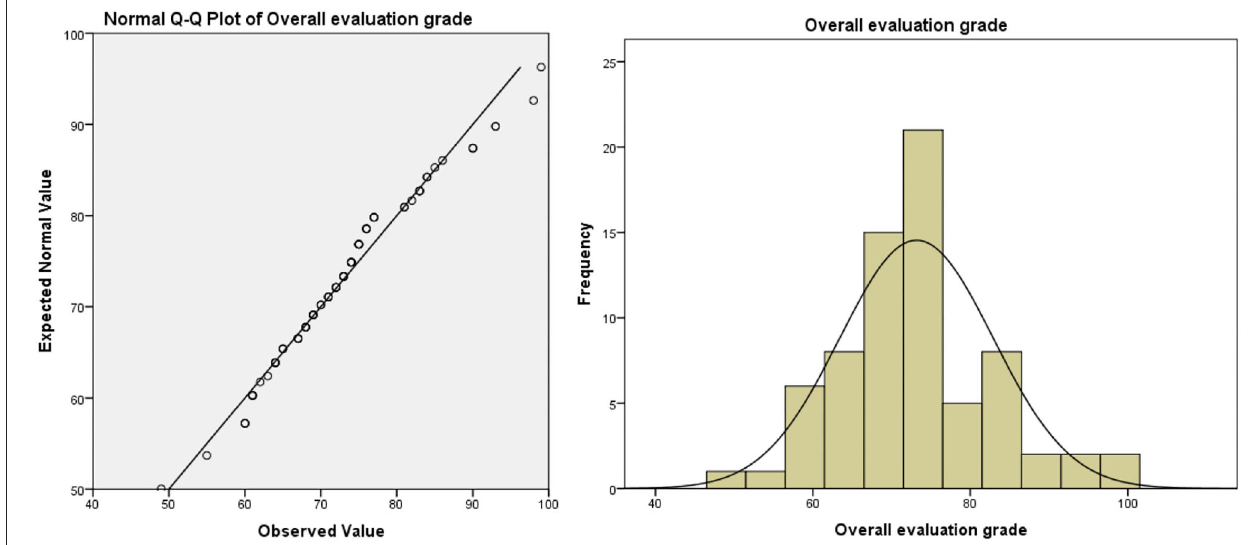
FIGURE 3 | Overall evaluation grade of teacher-oriented graduates majoring in bio-pharmaceutical.